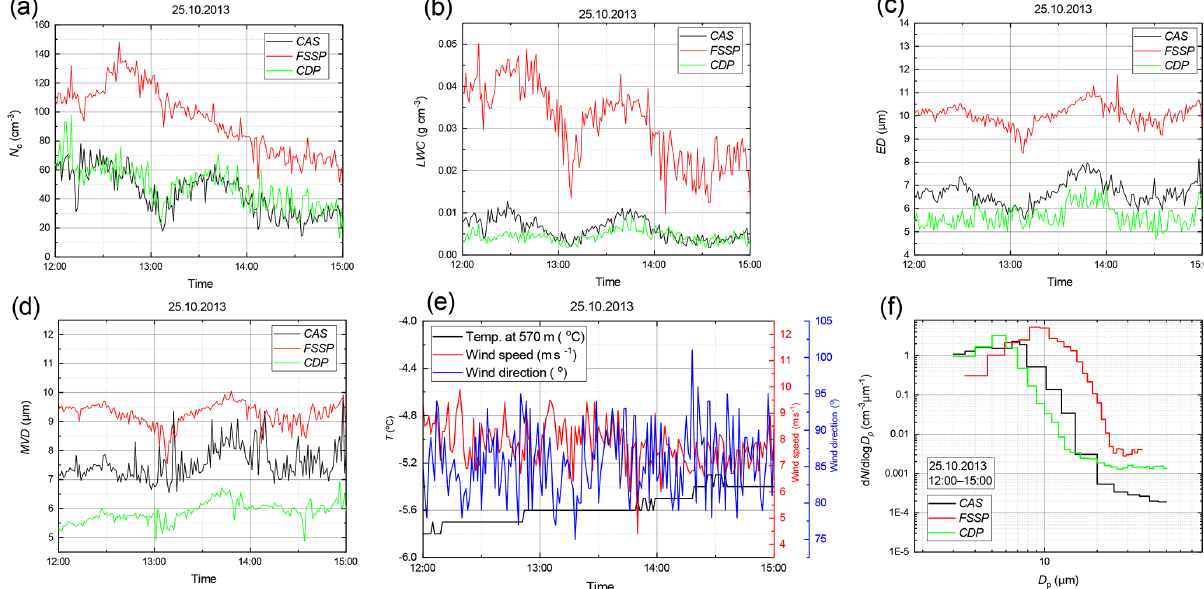
Figure 4. Time series for the 12 November case from 15:00 to 18:00. The main parameters as they were derived/measured from all three cloud probes: (a) N c ; (b) LWC; (c) ED; (d) MVD; (e) temperature, wind speed, wind direction; and (f) size distribution. All three instruments were pointing in the same direction. This resulted in high agreement in N c for all three probes. In addition, we also noticed good agreement in LWC. The main reason for slight differences in ED and MVD was the different sizing ability of the